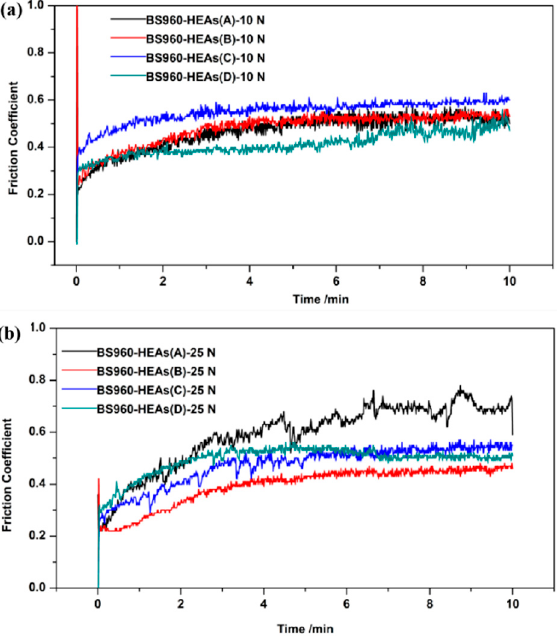
Figure 7. Friction coefficients of FeCoNiCrMo 0.2 high entropy alloy coating sprayed by plasma with different currents ( a ) 10 N, ( b ) 25 N.